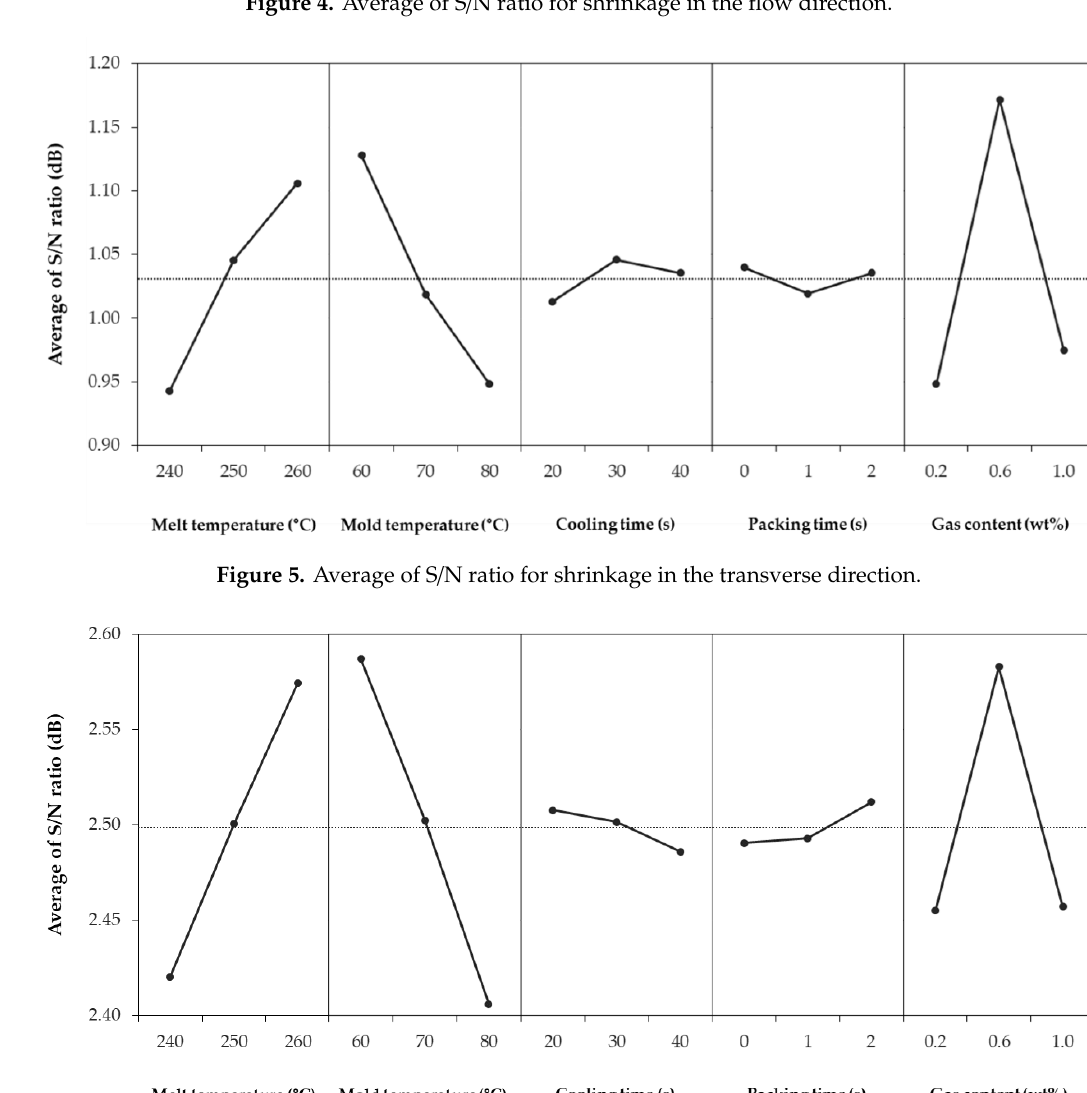
Figure 4. Average of S/N ratio for shrinkage in the flow direction.